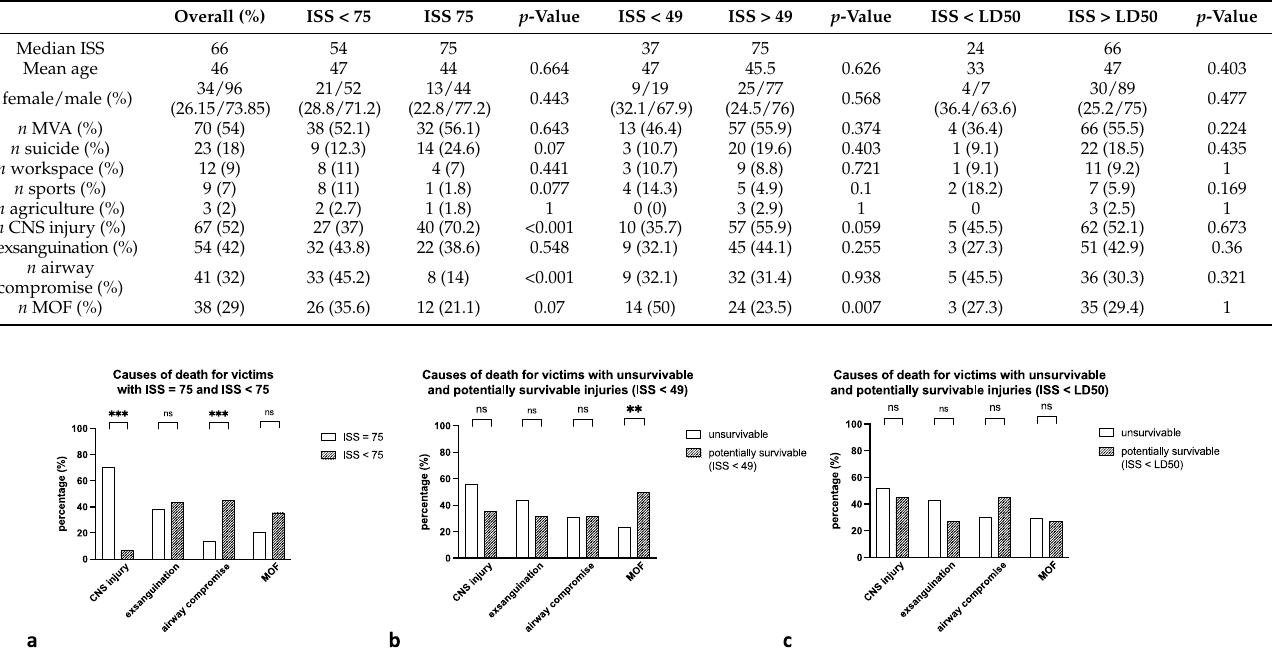
Figure 6. Median and IQR of injury severities according to the AIS-98 within the respective ISS body regions for prehospital deaths and submaximal (ISS < 75) injury ( a ), unsurvivable (ISS > 49) and potentially survivable (ISS < 49) injury ( b ), and unsurvivable (ISS > LD50) and potentially survivable (ISS < LD50) injury ( c ). There were significant differences in all body regions except for the external. **** p < 0.0001, *** p < 0.001, * p < 0.5, ns not significant. Symbol: median, whiskers: IQR. 4. Discussion Means to identify injury patterns and causes of death in deceased patients are autopsy and postmortem CT imaging [16,17]. From a forensic perspective, autopsy remains the gold standard for the evaluation of injury patterns. Postmortem CT imaging can be a useful addition, especially for the evaluation of osseous injuries to the facial bones, spine, and extremities [18]. Thus, in Switzerland, postmortem CT scans are routinely obtained in these cases. Using ISS data obtained from congruously unique postmortem whole-body CT data and autopsies of prehospital trauma victims within a